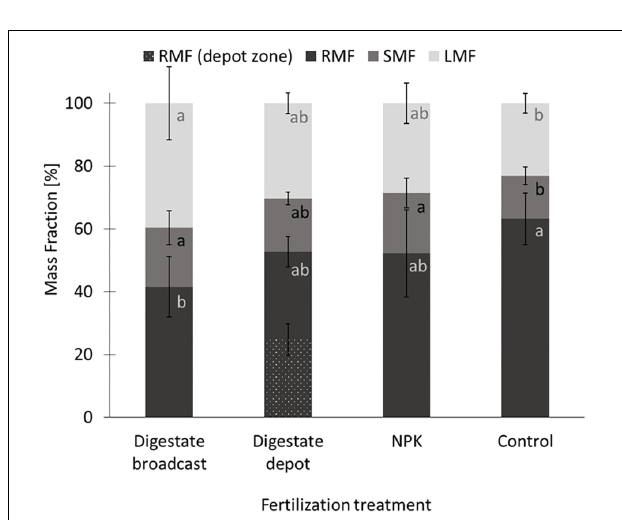
FIGURE 4 | Mass fractions of S. hermaphrodita grown in rhizotrons for 90 days. RMF, root mass fraction; depot zone, zone in a 6 cm radius around the digestate depot; SMF, stem mass fraction; LMF, leaf mass fraction. All fertilization treatments were adjusted to a digestate application of 40 t ha − 1 . Digestate broadcast: homogeneously incorporated in the top 20 cm; Digestate depot: localized digestate application; NPK: homogeneously incorporated in the top 20 cm; Control: no fertilization; n = 8 replicates for each treatment. Values labeled with the same letter are not significantly different at p < 0.05. Error bars indicate the standard